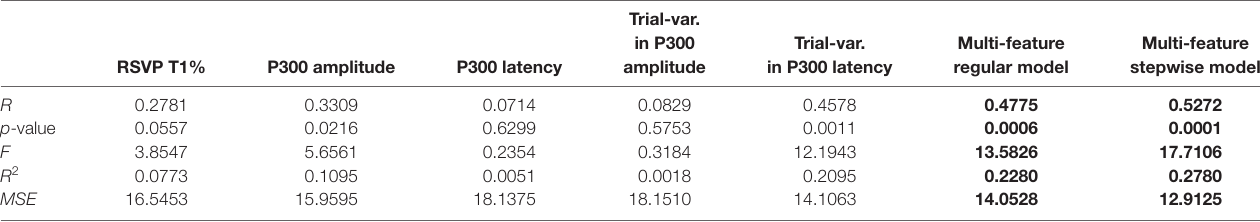
TABLE 1 | The predictability of P300 speller for single- and multi-feature predictors.